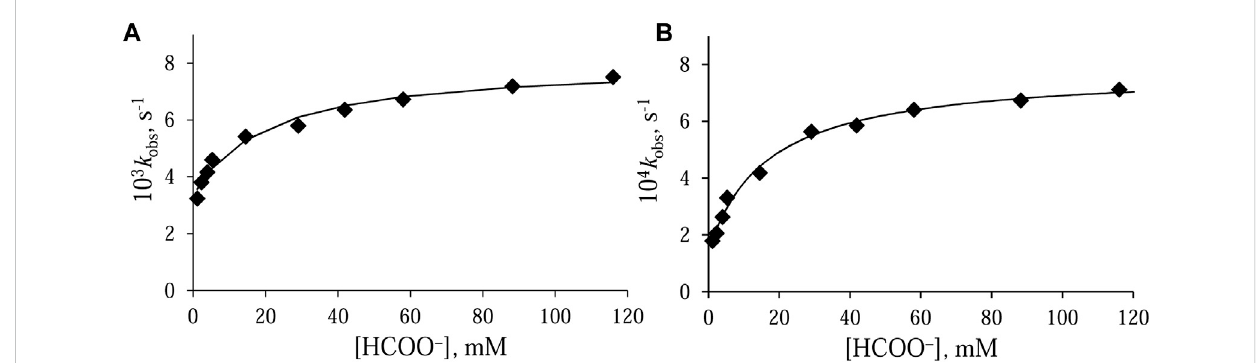
FIGURE 3 Dependence of k obs on formate concentration for the anation of (A) [Ru II (terpy)(en)(H 2 O/EtOH)] 2+ and (B) [Ru II (terpy)(ampy)(H 2 O/EtOH)] 2+ in water/ ethanol mixture (1:9, v/v). Experimental conditions: [Ru(II)] = 0.106 mM, T = 36.8 °